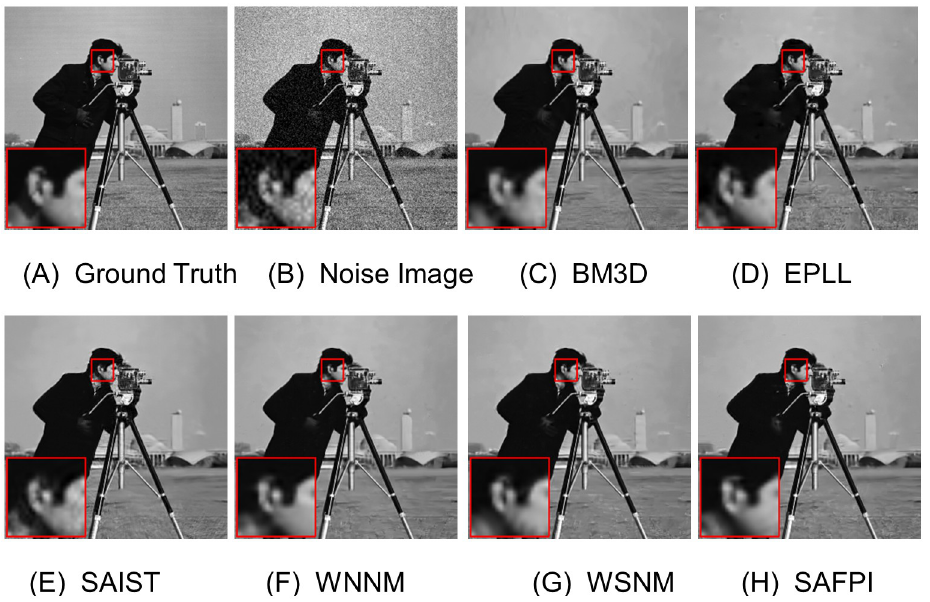
Fig 4. Denoising results on image Cameraman by different methods (noise level σ Noisy Image (C) BM3D, PSNR = 30.48 (D) EPLL, PSNR = 30.34 (E) SAIST, PSNR = 30.45 (F) WNNM, PSNR = 30.64 (G) WSNM, PSNR = 30.64 (H) SAFPI, PSNR =